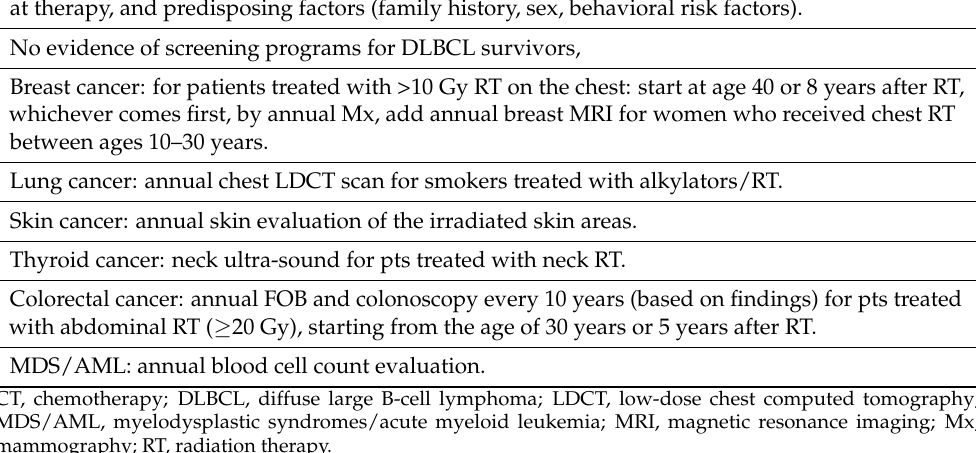
Table 3. Highlights emerging from the systematic review and expert panel advice: suggested follow- up schemes for early diagnosis of second